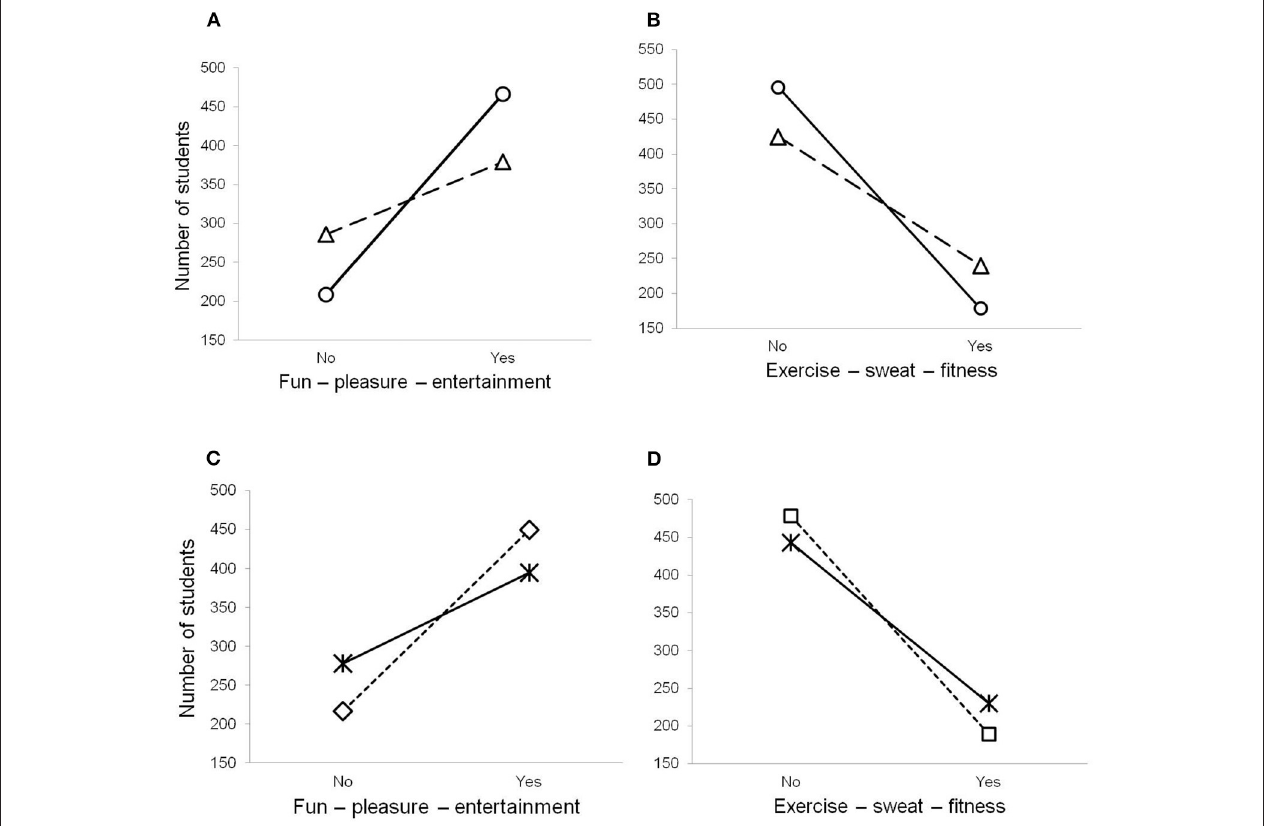
FIGURE 1 | Interaction plots (A) between the first profile of PE classes (fun–pleasure–entertainment) and gender (female marked as a circle and male marked as a triangle ); (B) between the second profile of PE classes (exercise–sweat–fitness) and gender (female marked as a circle and male marked as a triangle ); (C) between the first profile of PE classes (fun–pleasure–entertainment) and school level (middle marked as a square and high marked as a cross ); and (D) between the second profile of PE classes (exercise–sweat–fitness) and school level (middle marked as a square and high marked as a cross ).